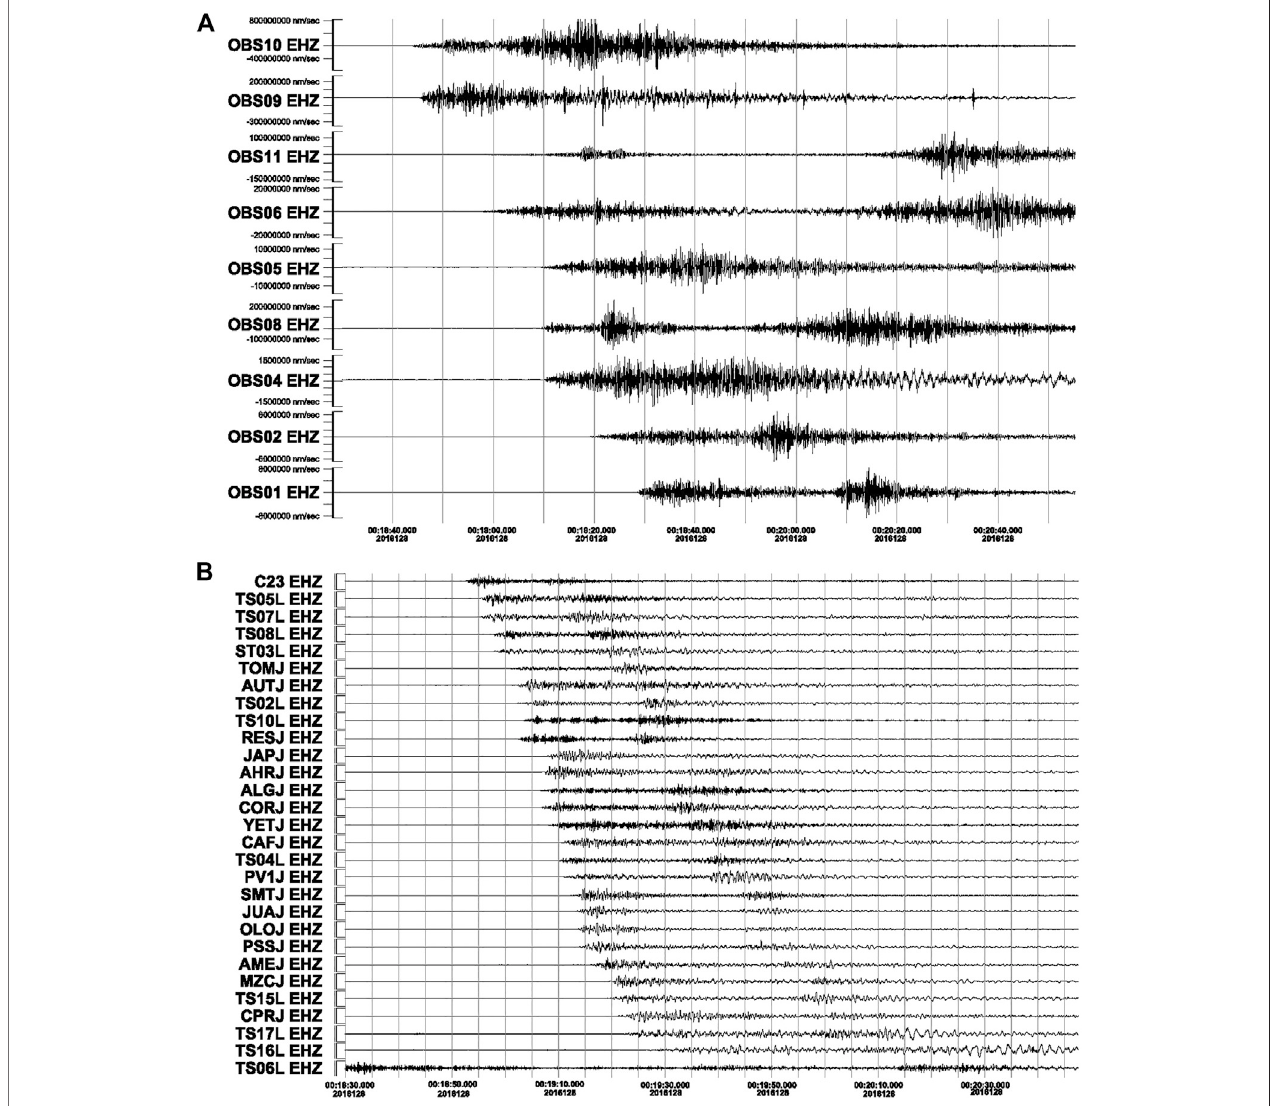
FIGURE 2 | Seismic traces corresponding to May 7, 2016, earthquake at 00:18 recorded by (A) Ocean Bottom Seismometers (OBS) and (B) Temporary seismic (TN) and RESAJ networks. Stations ordered from nearest (OBS10) to the furthest (TS06L) to the earthquake.